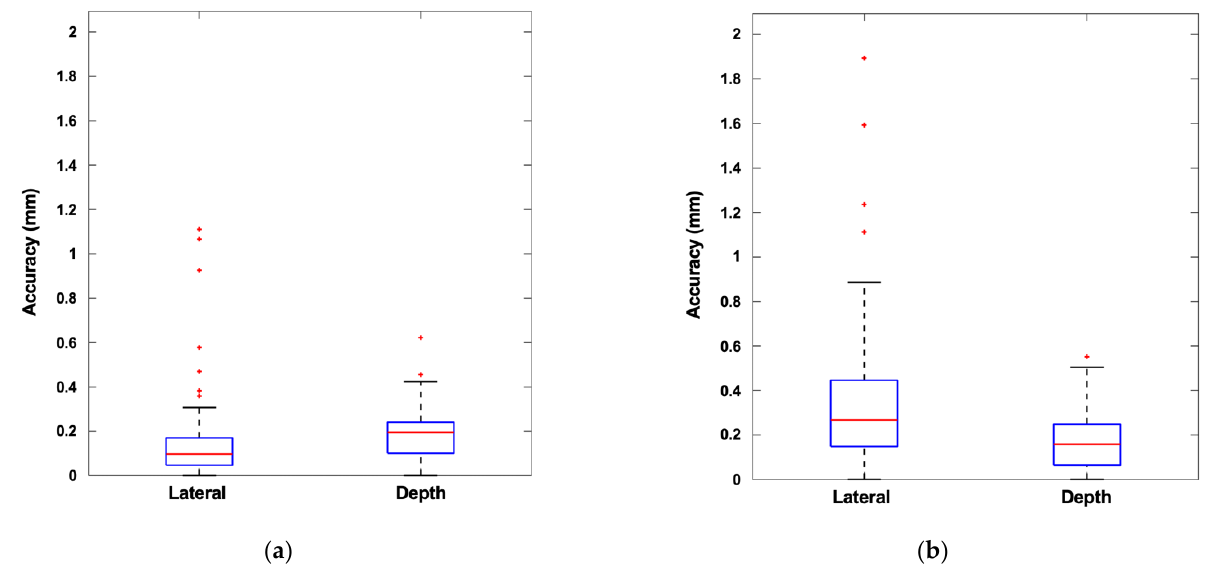
Figure 8. Vessel centroid estimation accuracy: ( a ) femoral artery; ( b ) femoral vein. Box-and-whiskers format displays median, interquartile range (IQR, box), ± 1.5 IQR (whiskers), and individual data points outside of whiskers.